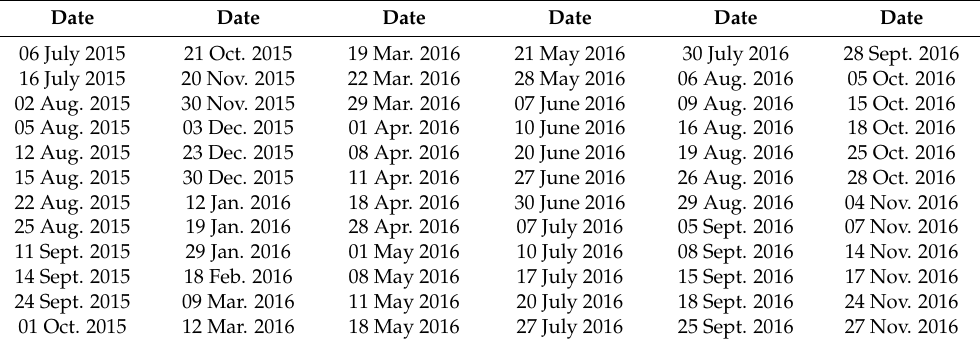
Table 3. Sentinel-2